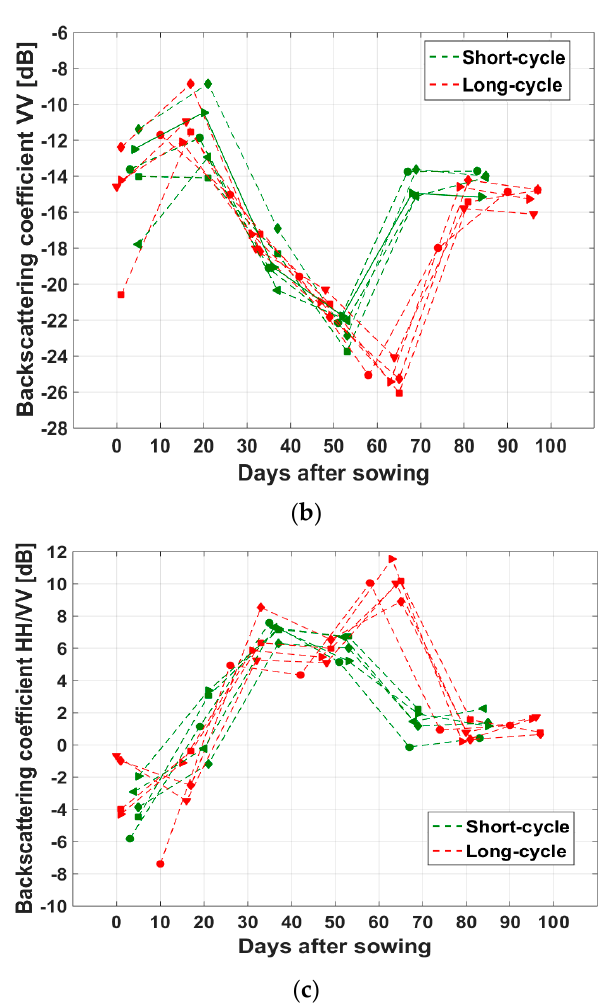
Figure 8. Variation of ( a ) HH, ( b ) VV backscattering coefficient, and ( c ) HH/VV of the 5 selected short -cycle sampled fields (in green), and 5 long-cycle fields (in red) extracted from CSK images of 6 dates, versus the sowing date of each field.